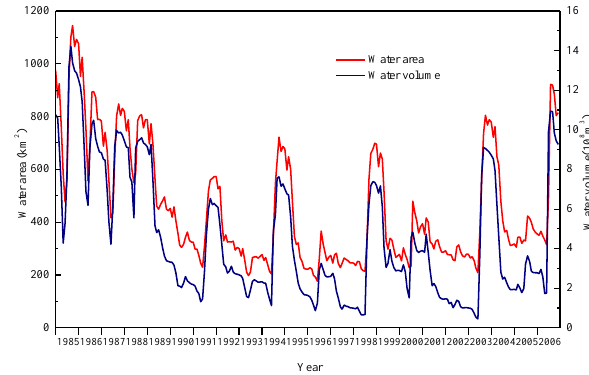
Fig. 6. Comparison between simulated and observed monthly outflow (Binzhouxian station) during the validation period in the Zhalong Wetland, Northeast China.